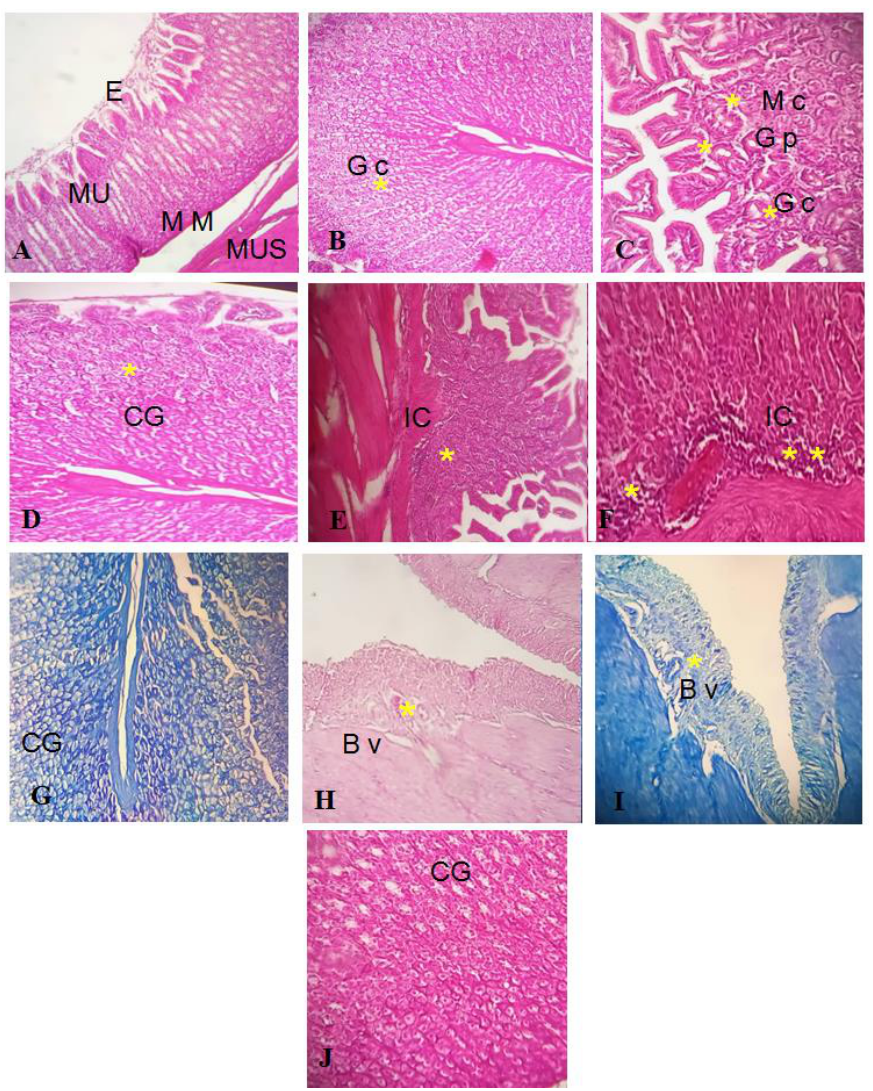
Figure 11. (( A – C ): control group I) Normal stratification of stomach layer. ( E ): epithelium, Mu: mucosa, MM: muscularis mucosa, Mus: muscularis. ( B ): Gc: glandular cells, ( C ): PG: pyloric